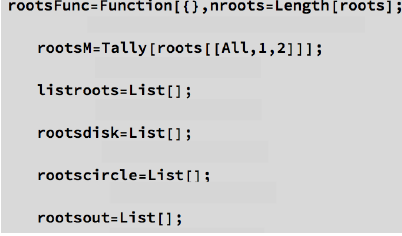
Figure 28. Part of the code structure of the [ARoot] algorithm responsible for the computation of the roots of p